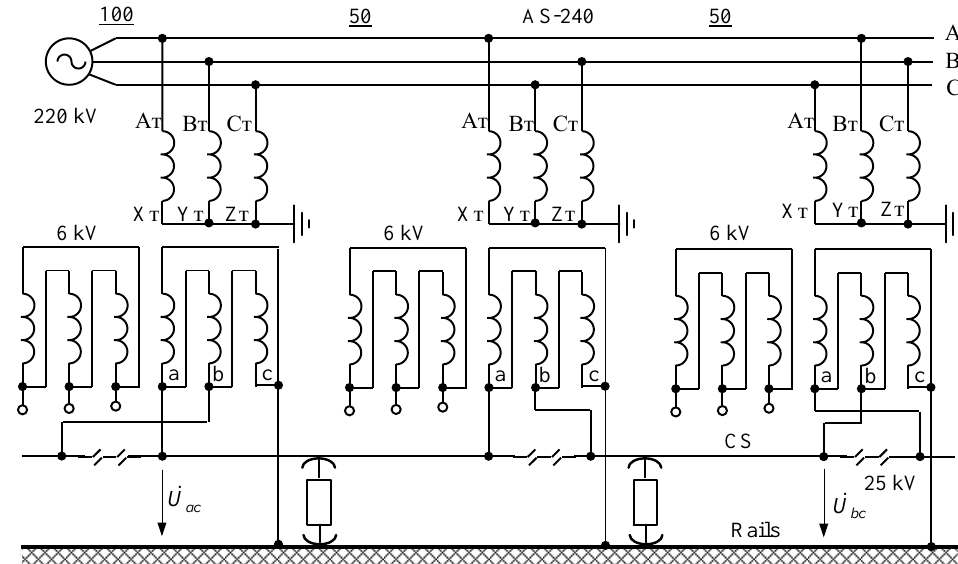
Figure 12. Diagram of a section of a standard 27.5 kV RPSS.